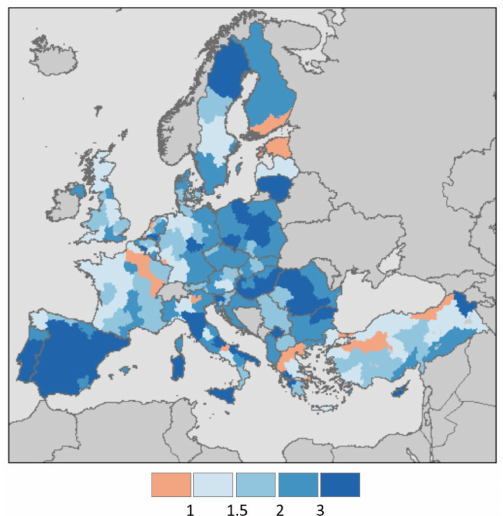
Figure 9. Spatial distribution of the ratio between the number of fAPAR anomalies < − 1 in the optimal period (see Sect. 3.3) dur- ing low-yield years (yield anomalies < − 1) and other years (yield anomalies ≥ −